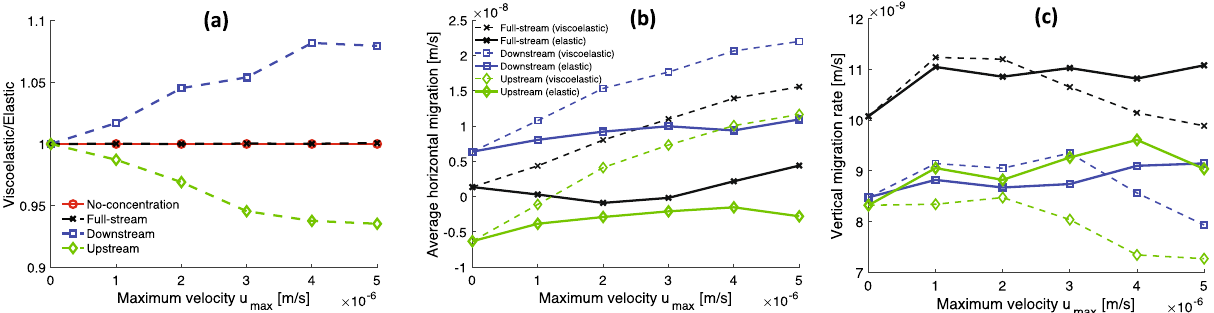
Figure 4. Comparison of net growth and migration in full-stream, downstream, and upstream nutrient configurations over a range of shear flow values between an elastic biofilm ( E = 50 Pa) and a viscoelastic biofilm ( E = 50 Pa, η = 5 × 10 4 Pa.s). ( a ) The ratio of the biomass of the viscoelastic biofilm to the biomass of the elastic biofilm at 2.5 h. The elastic biofilm tends to overestimate the growth in the upstream configuration and underestimate the growth in the downstream configuration. ( b ) The migration rate in the x -direction, i.e., the velocity of the x -coordinate of the center of mass. The nearly constant offset between the migration rate in graphs of the downstream and upstream configurations provides a measure of the migration rate toward the nutrient source. The full-stream configuration is approximately the average of the downstream and upstream migration rate, which provides a measure of the migration rate in response to shear flow. ( c ) The migration rate in the y -direction, i.e., the velocity of the y -coordinate of the center of mass. The elastic biofilm overestimates the vertical migration rate at large values of u max is also different in the full-stream nutrient configuration even though their net growth is approximately equal (Fig. 4a). The fact that the x -direction migration rate downstream appears graphically as an approximately vertical shift from the x -direction migration rate upstream for both biofilms in 4b suggests that the migration rate due to growth and the migration rate due to shear deformation is approximately additive, and the migration rate due to growth is approximately constant. Assuming the upstream velocity is U up ≈ − U growth + U shear and the downstream velocity is U down ≈ U growth + U shear , where U growth and U shear are the magnitude of the contribution to the migration rate due to growth and the shear flow respectively, then U growth ≈ ( 1 / 2 )( U down − U up ) . Thus, taking the mean value of U growth over the range of u max for the viscoelastic and elastic biofilm gives a measure of for the migration rate due to growth: U growth = ( 0.021 ± 0.002 ) mm/hr where the reported error is the standard deviation of U growth . The migration speed due to the shear flow, U shear , can also be estimated from the data as U shear ≈ ( 1 / 2 )( U down + U up ) ≈ U full , where U full is the migration speed of the biofilm in the full-stream nutrient configuration. The migration speed due to the shear flow at u max = 5 × 10 − 6 m/s is U shear ≈ 0.056 mm/h for the viscoelastic biofilm and U shear ≈ 0.016 mm/h for the elastic biofilm. The y -coordinate migration rate, shown in Fig. 4c, is similar for both biofilms at small flow rates, while at large flow rates, the elastic biofilm overestimates the y -direction migration rate. Viscoelastic biofilms.